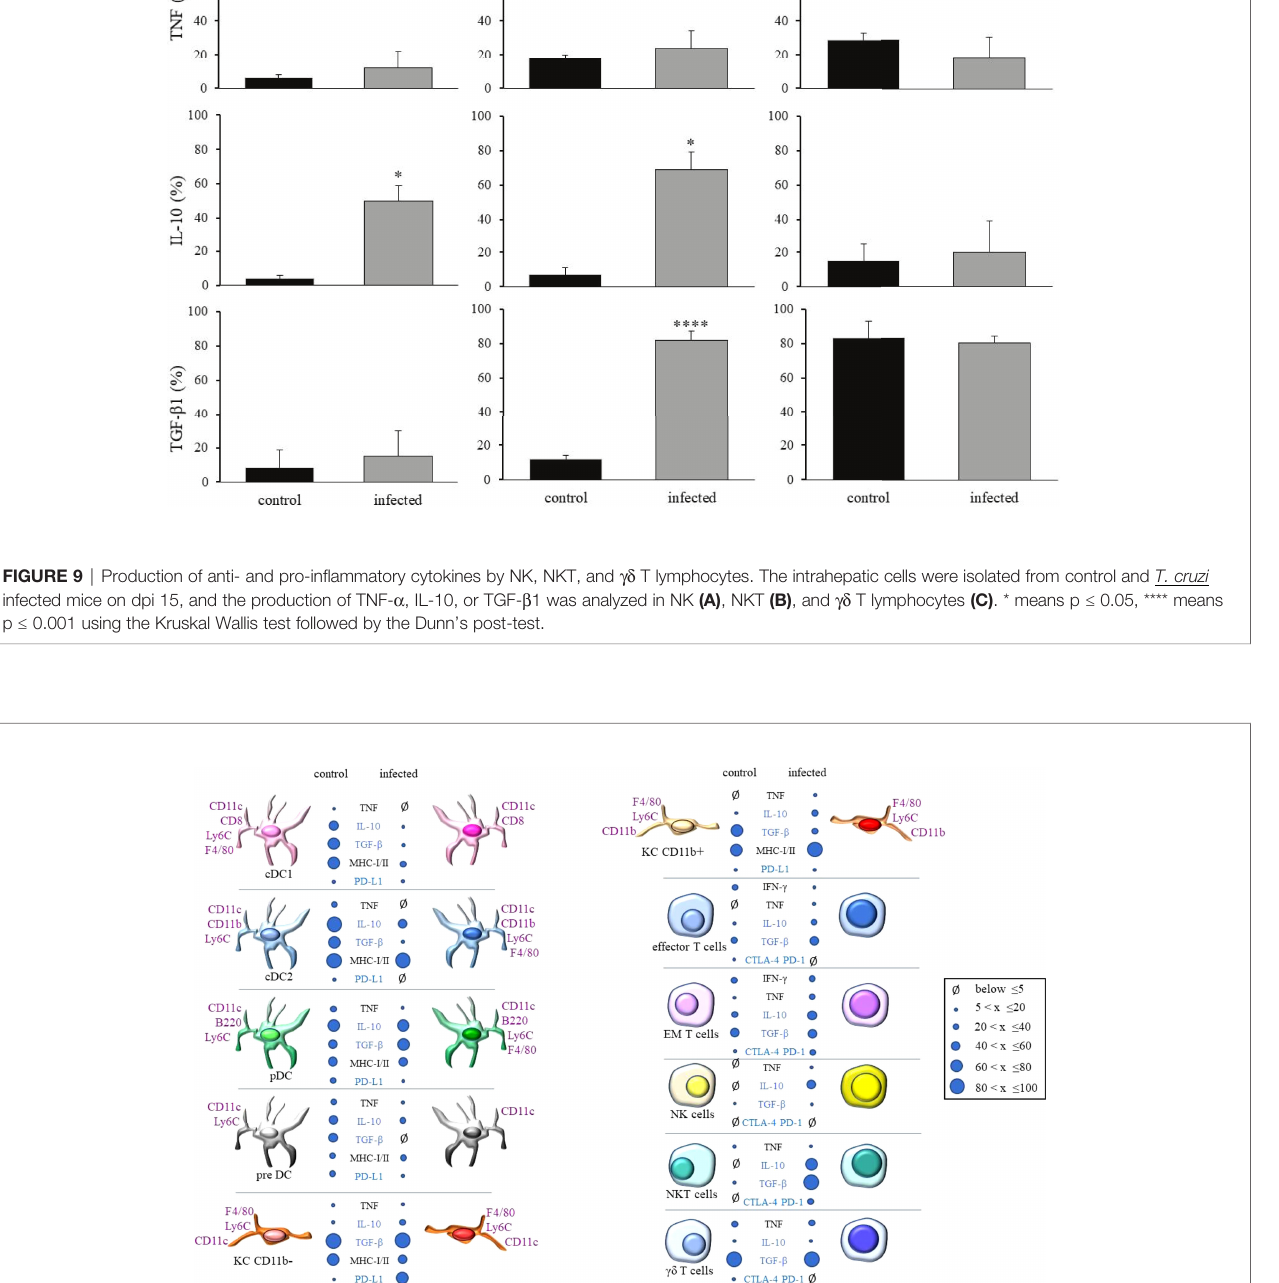
FIGURE 10 | Summary of phenotypic modulations observed in hepatic cells from control and T. cruzi infected mice obtained on dpi 15 (acute phase). The results obtained by fl ow cytometry were strati fi ed in this chart according to the frequency of cells expressing each marker. Subpopulations with up to 5% of frequency were considered not represented. The dimension of each dot proportionally represents the frequency of each subpopulation found in fl ow cytometry analysis. According to the legend, the intervals vary from 5% to 20% of positive cells, 20% (exclusive) to 40%, and so on. Effector and EM lymphocytes represent the results for CD4 or CD8